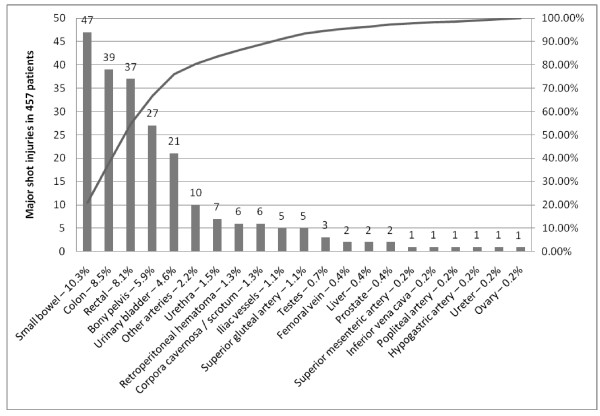
Types of major injury related to shot trauma to the buttock in 457 patients.